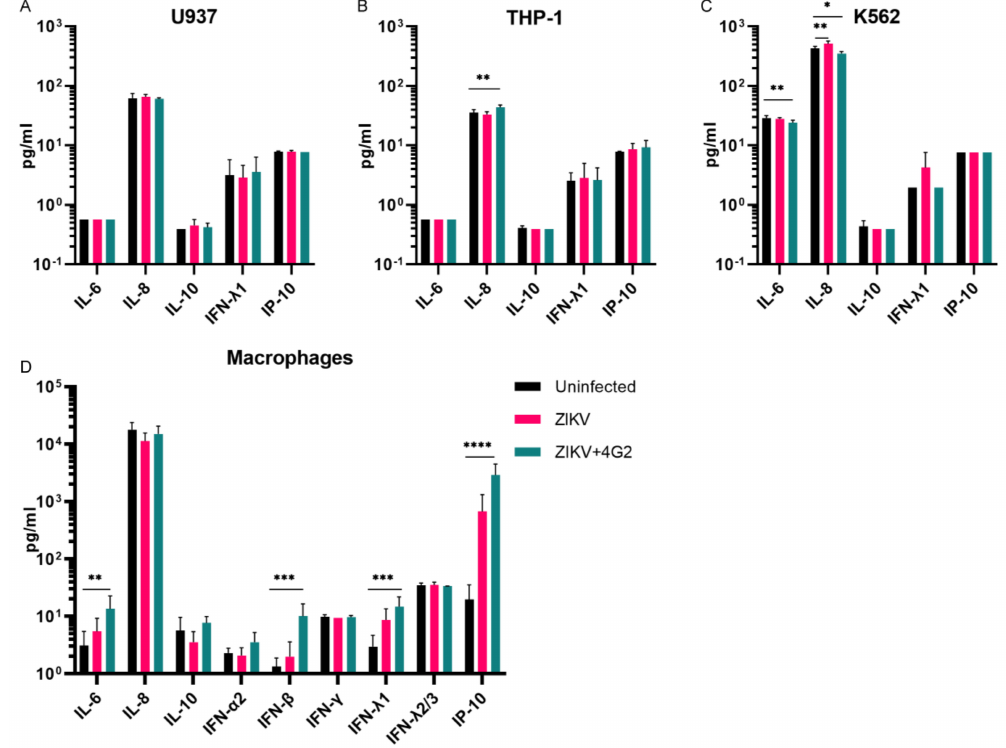
Figure 5. A modest increase of cytokine concentrations in supernatants of Fc γ R-bearing cells during ADE of ZIKV infection. A panel of 13 cytokines were determined in U937 cells ( A ), THP-1 cells ( B ), K562 cells ( C ) and monocyte-derived macrophages ( D ) 48 h after mock infection or infection with ZIKV or ZIKV that was pre-incubated with 1 µ g/mL of the pan-flavivirus humanized monoclonal antibody 4G2 (hu4G2). Only the cytokines that could be detected in the supernatants of the cells are illustrated in the graphs. Bars represent mean ± SEM. Statistical significance was determined with a one-way ANOVA with Dunnett’s post hoc test, comparing uninfected cells with ZIKV infected and ZIKV + hu4G2 infected. * p < 0.05, ** p < 0.01, *** p < 0.001, **** p <